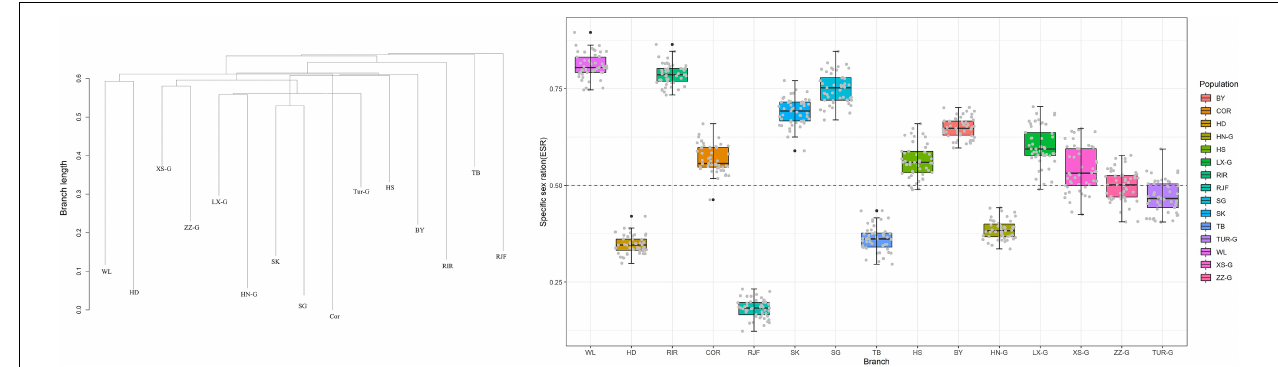
FIGURE 5 | The boxplots summarize the distributions of the posterior mans of the ESR for each population, for the 50 pseudo-replicated datasets. The dotted line indicates a balanced ESR ( ξ =